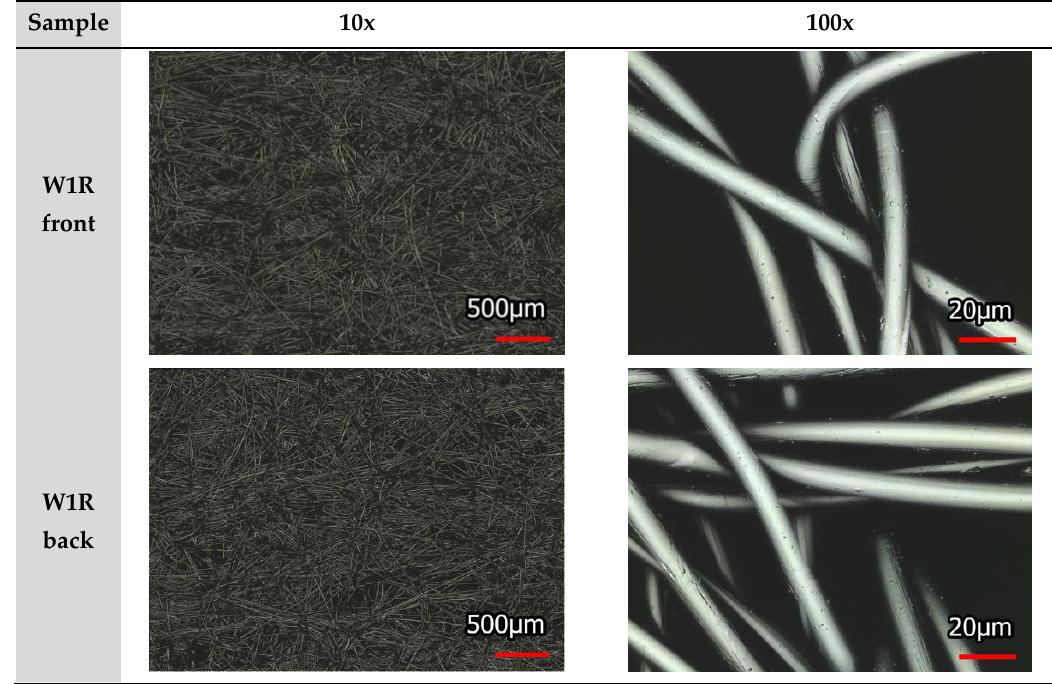
Figure A4. XPS survey scan of woven cotton wipe (W3), ( A ) W3R, ( B ) W3RQ, ( C ) W3P, ( D ) W3PQ.